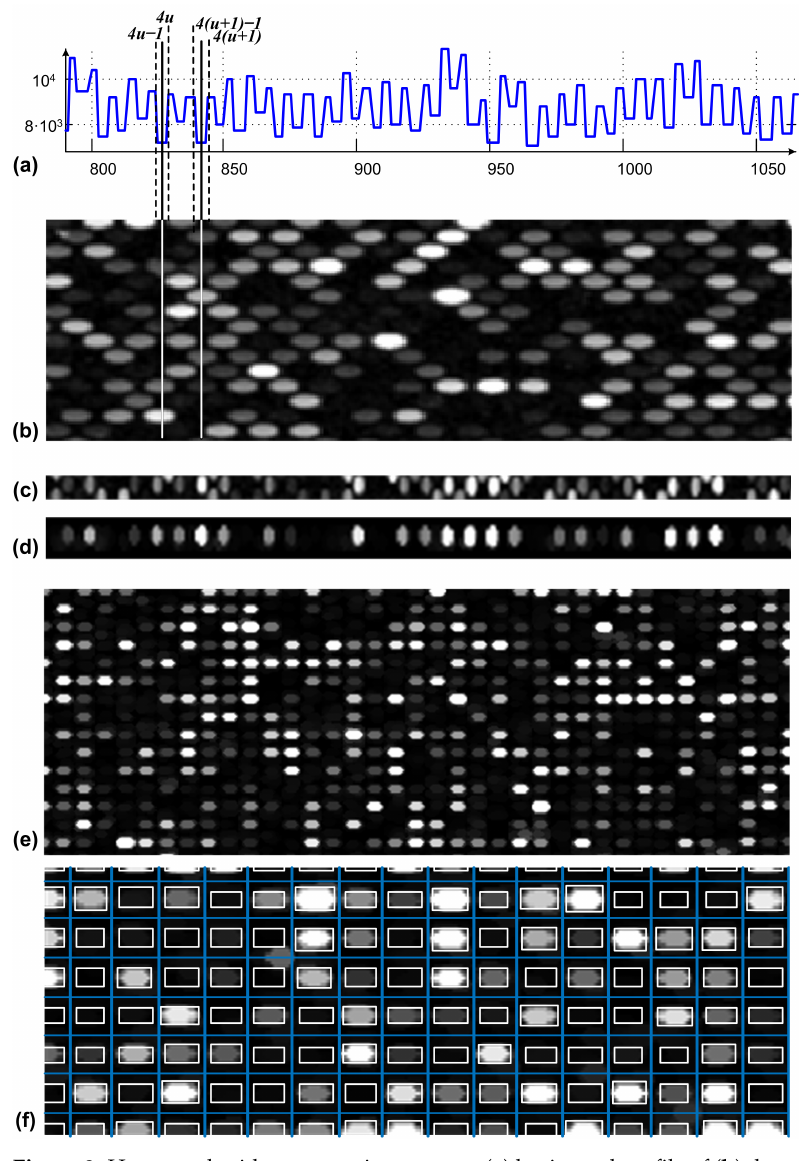
Figure 3. Hexagonal grid segmentation process: ( a ) horizontal profile of ( b ) the preprocessed microar- ray image, ( c ) selected lines based on separation lines, ( d ) morphological exclusion of neighboring spots, ( e ) final rectangular even spots I ev and ( f ) segmentation of the rectangular